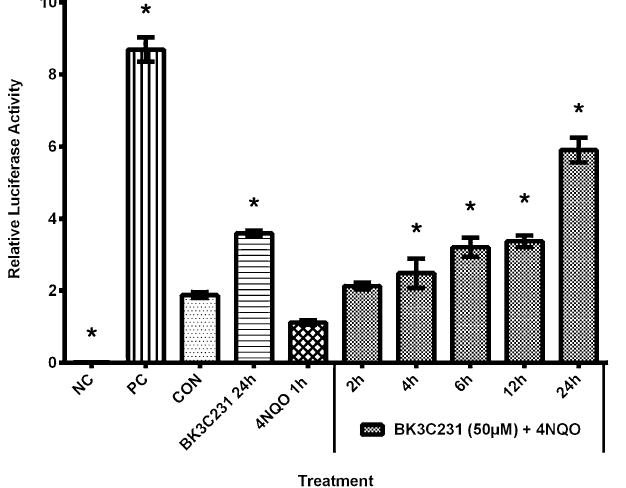
Figure 4. Effect of BK3C231 pretreatment on ARE promoter activity. The relative luciferase activity which indicates ARE promoter activity was observed at basal level in untreated control cells (CON). Treatment of cells with 4NQO only (4NQO 1 h) decreased ARE promoter activity over untreated control. However, in cells treated only with BK3C231 (BK3C231 24 h), relative luciferase activity significantly increased over 4NQO-treated cells (4NQO 1 h). BK3C231 treatment alone also enhanced relative luciferase activity over the basal level in the untreated control (CON). BK3C231 pretreatment significantly increased relative luciferase activity from 4 h till 24 h over 4NQO-treated cells (4NQO 1 h). Cells were transfected with ARE reporter construct and pretreated with BK3C231 before 4NQO exposure as mentioned in “Results”. Subsequently, the dual-luciferase assay was performed to determine the firefly and Renilla luciferase activities. Cells transfected with Cignal negative control and positive control reporter constructs were used as the negative control (NC) and positive control (PC) for this assay. Each data point was expressed as mean ± SEM from at least three independent experimental replicates. *p < 0.05 against 4NQO 1